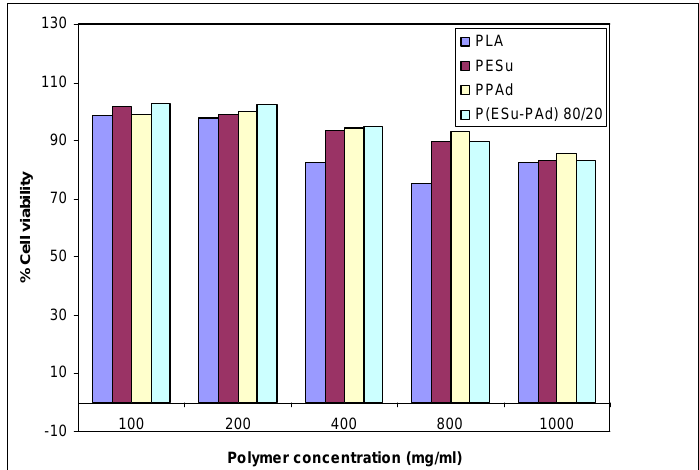
Figure 6. HUVEC cells viability after incubation for 24 hours with different polymers and different polymer